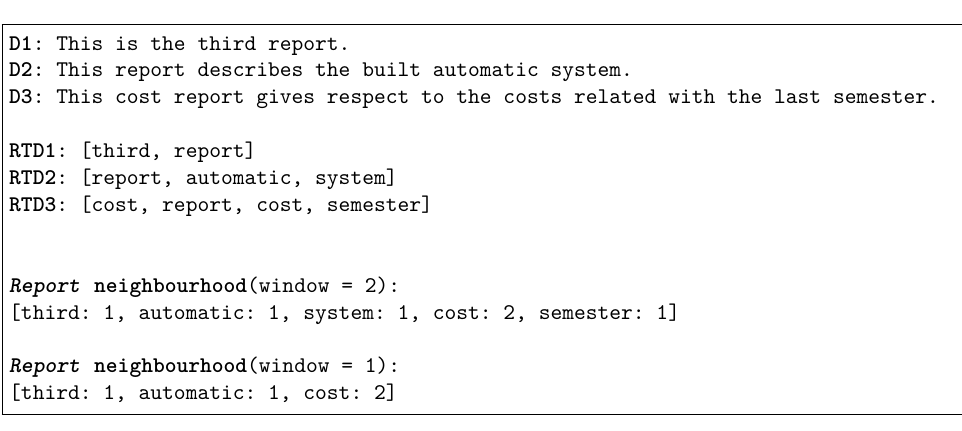
Figure 3. Neighbourhood vector creation of the report token based on three messages, considering a neighborhood window of 2 and 1.